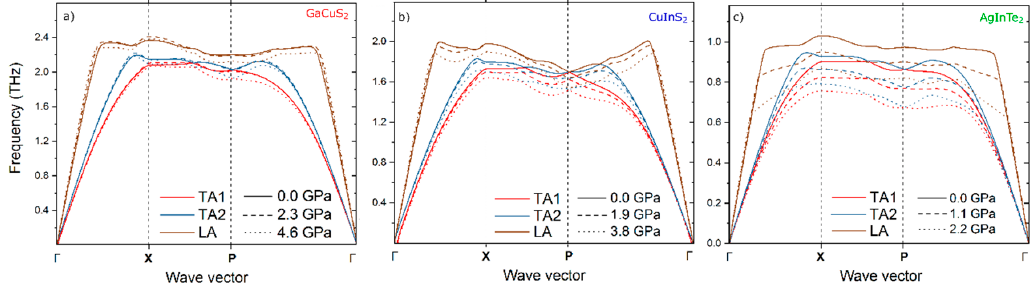
Figure 3. Acoustic phonon dispersion at different pressures of ( a ) CuGaS 2 , ( b ) CuInS 2 , and ( c ) AgInTe 2 . TA1 and TA2 are two transverse acoustic modes, and LA is a longitudinal acoustic mode.